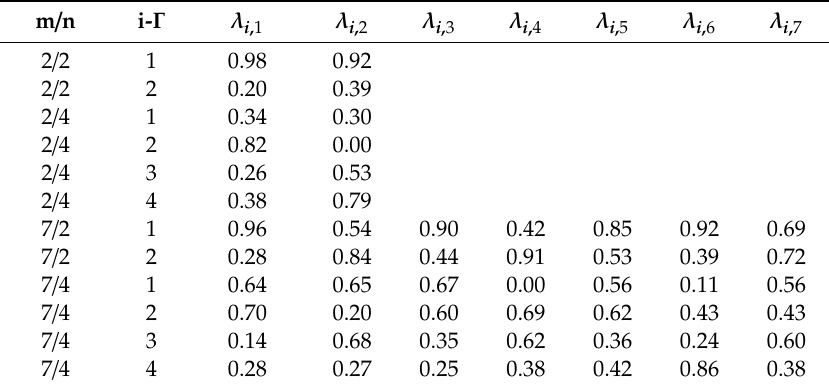
Table A3. Estimated weights for the di ff erent models.